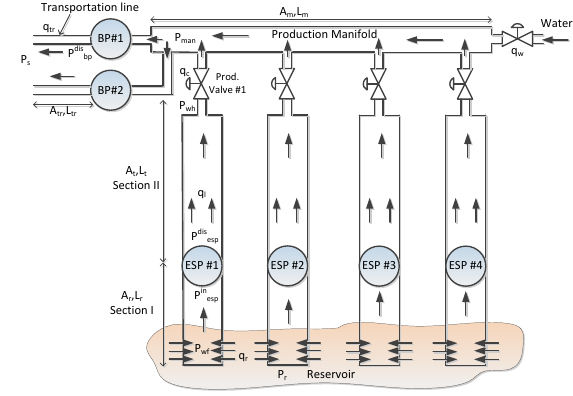
Figure 1: Schematic of ESP lifted oil field